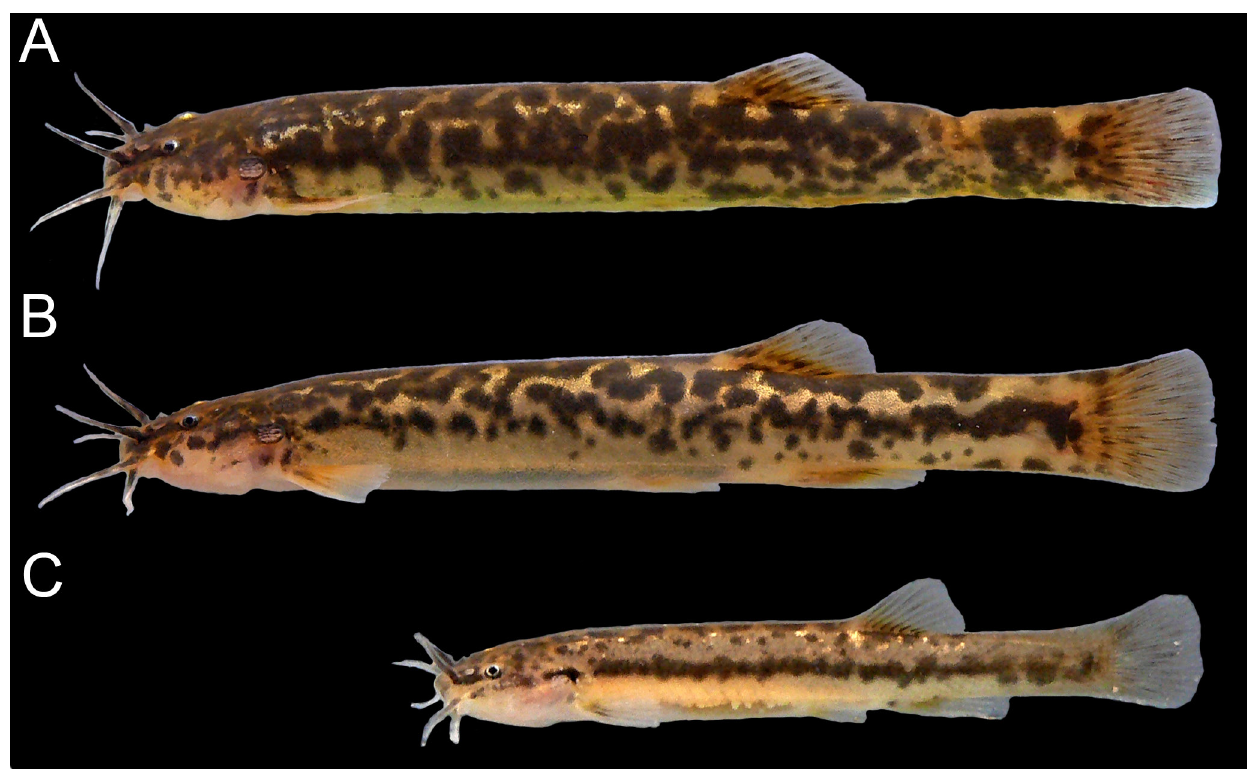
FIGURE 8 | Coloration pattern of Cambeva zonata , ( A–C ) UFRGS 24538, ( A ) 51.1 mm SL, ( B ) 48.4 mm SL, Betari River, Ribeira de Iguape River basin, and ( C ) 41.4 mm